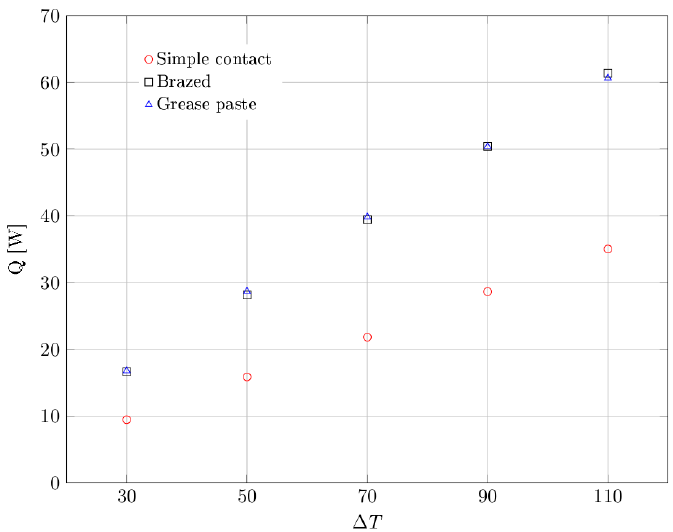
Figure 8. Dissipated heat power as a function of differential temperature, for each type of contact. Table 2. Experimental values of dissipated heat power as a function of differential temperature.